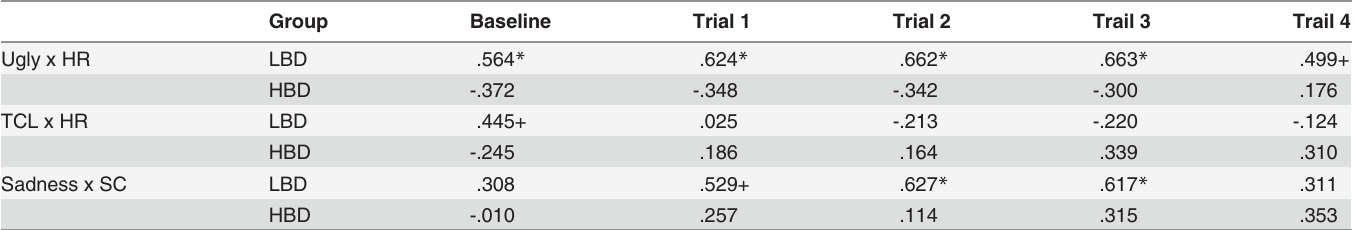
Table 3. Correlations between Ugly-negative Thoughts Checklist (TCL) scores and averaged heart rate (HR) and between Sadness scores and av- eraged skin conductance (SC). Group Baseline Trial 1 Trial 2 Trail 3 Trail 4 Ugly x HR LBD .564 * .624 * .662 * .663 * .499+ HBD -.372 -.348 -.342 -.300 .176 .445+ .025 -.213 -.220 -.124 -.245 .186 .164 .339 .310 .308 .529+ .627 * .617 * .311 -.010 .257 .114 .315